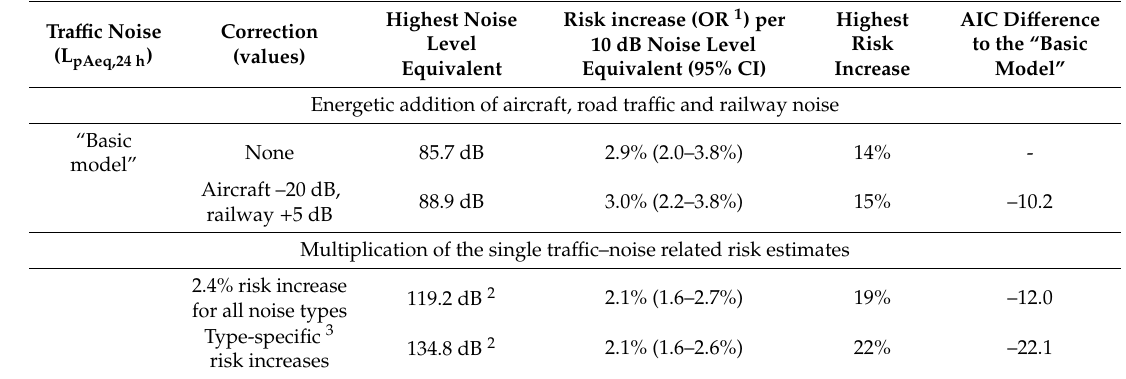
Table 2. Risk increase for cardiovascular diseases per 10 dB noise level equivalent (starting point: 40